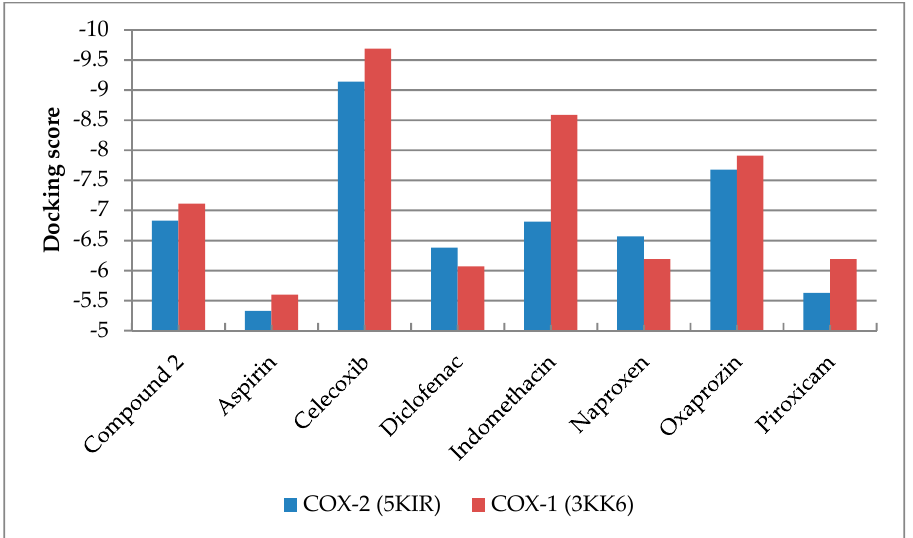
Figure 2. A comparative diagram of docking scores of compound 2 and selected NSAIDs against COX-1/COX-2 proteins .